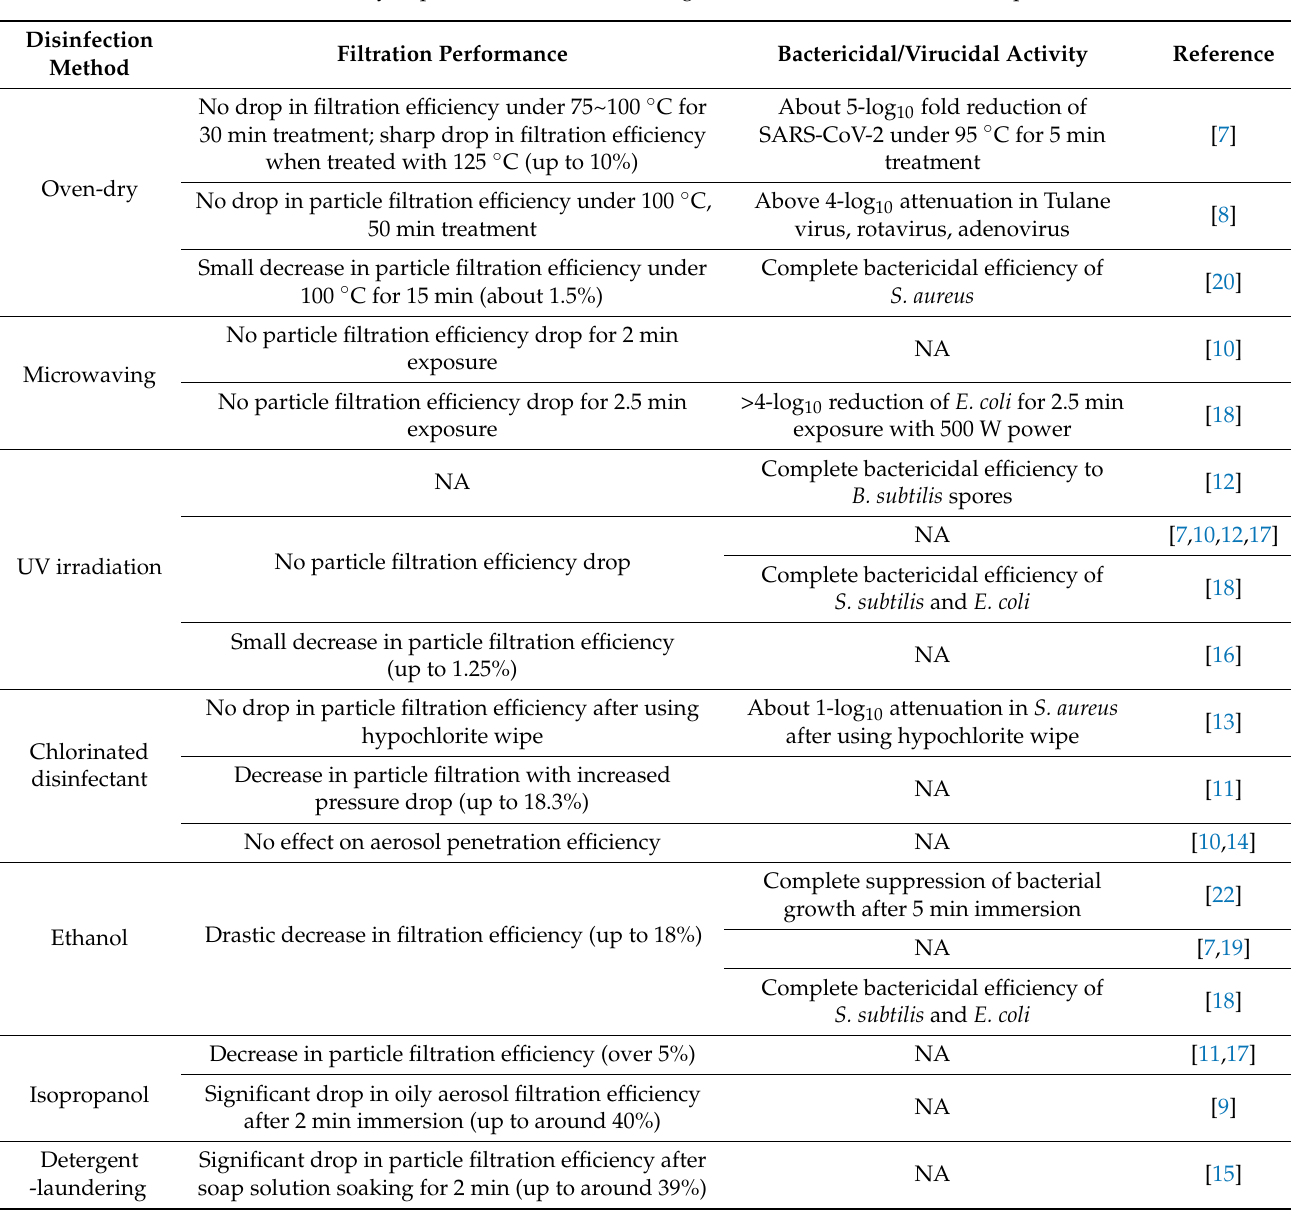
Table 1. Summary of previous studies examining the disinfection methods for